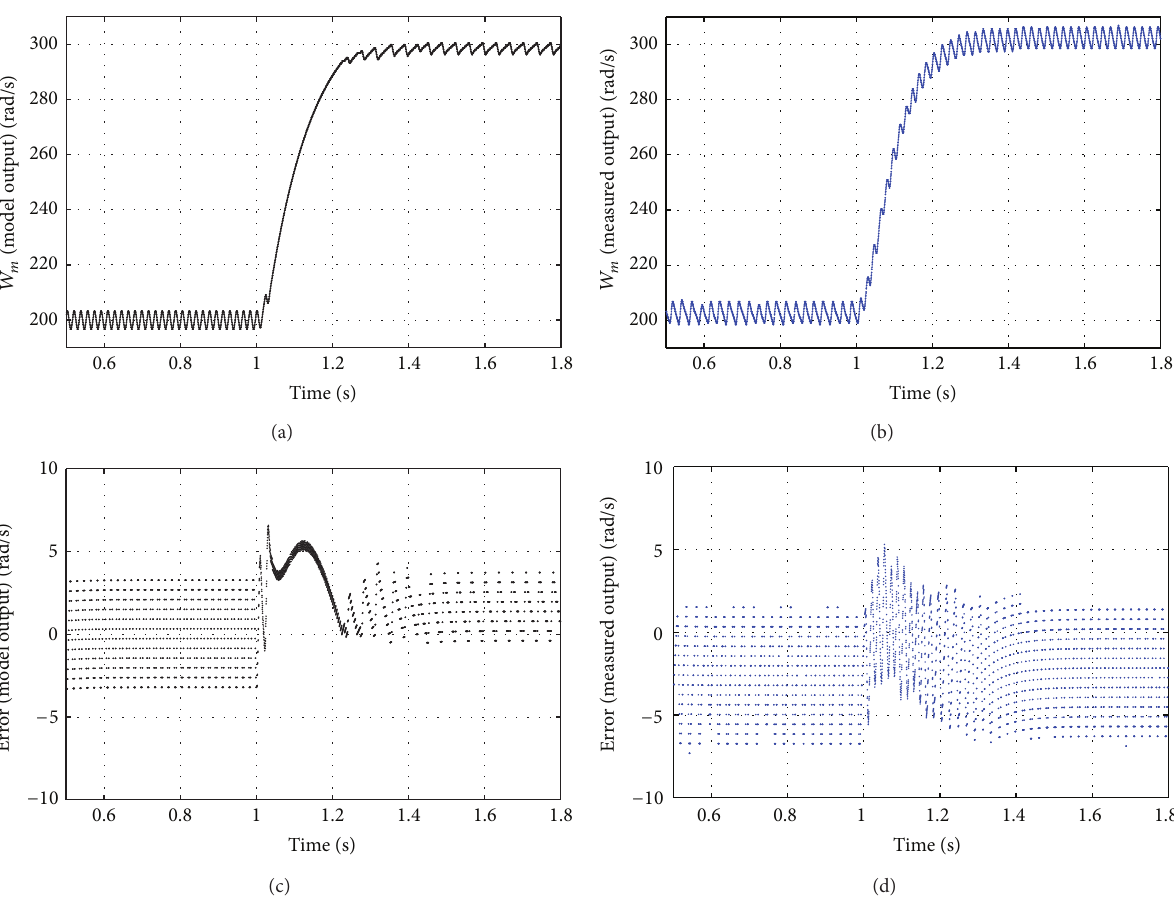
Figure 5: Simulated and experimental results when 𝑊 𝑚 experimental